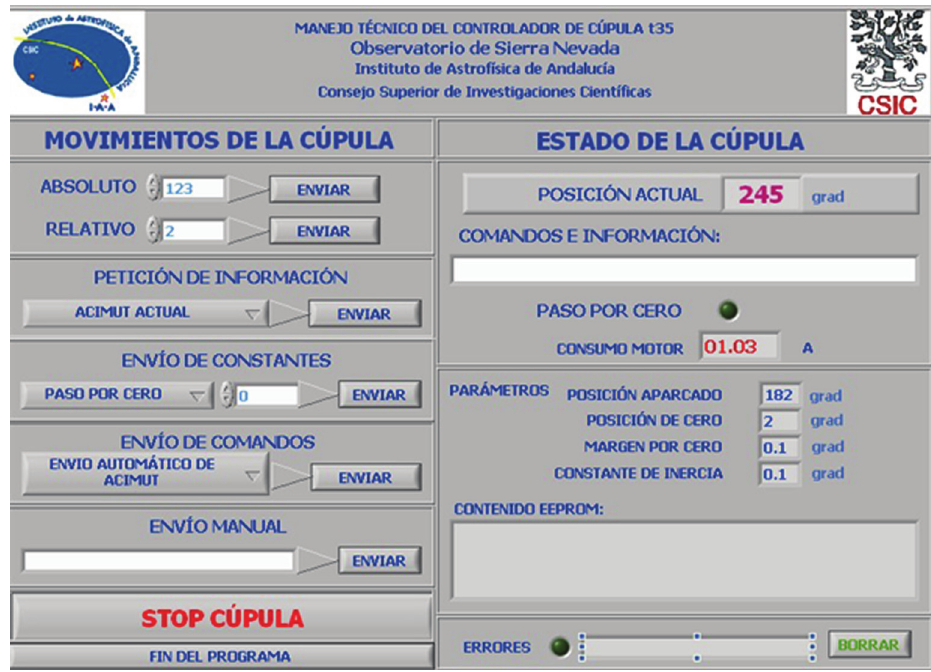
Figure 7: Graphic user interface of the engineering program developed for technical